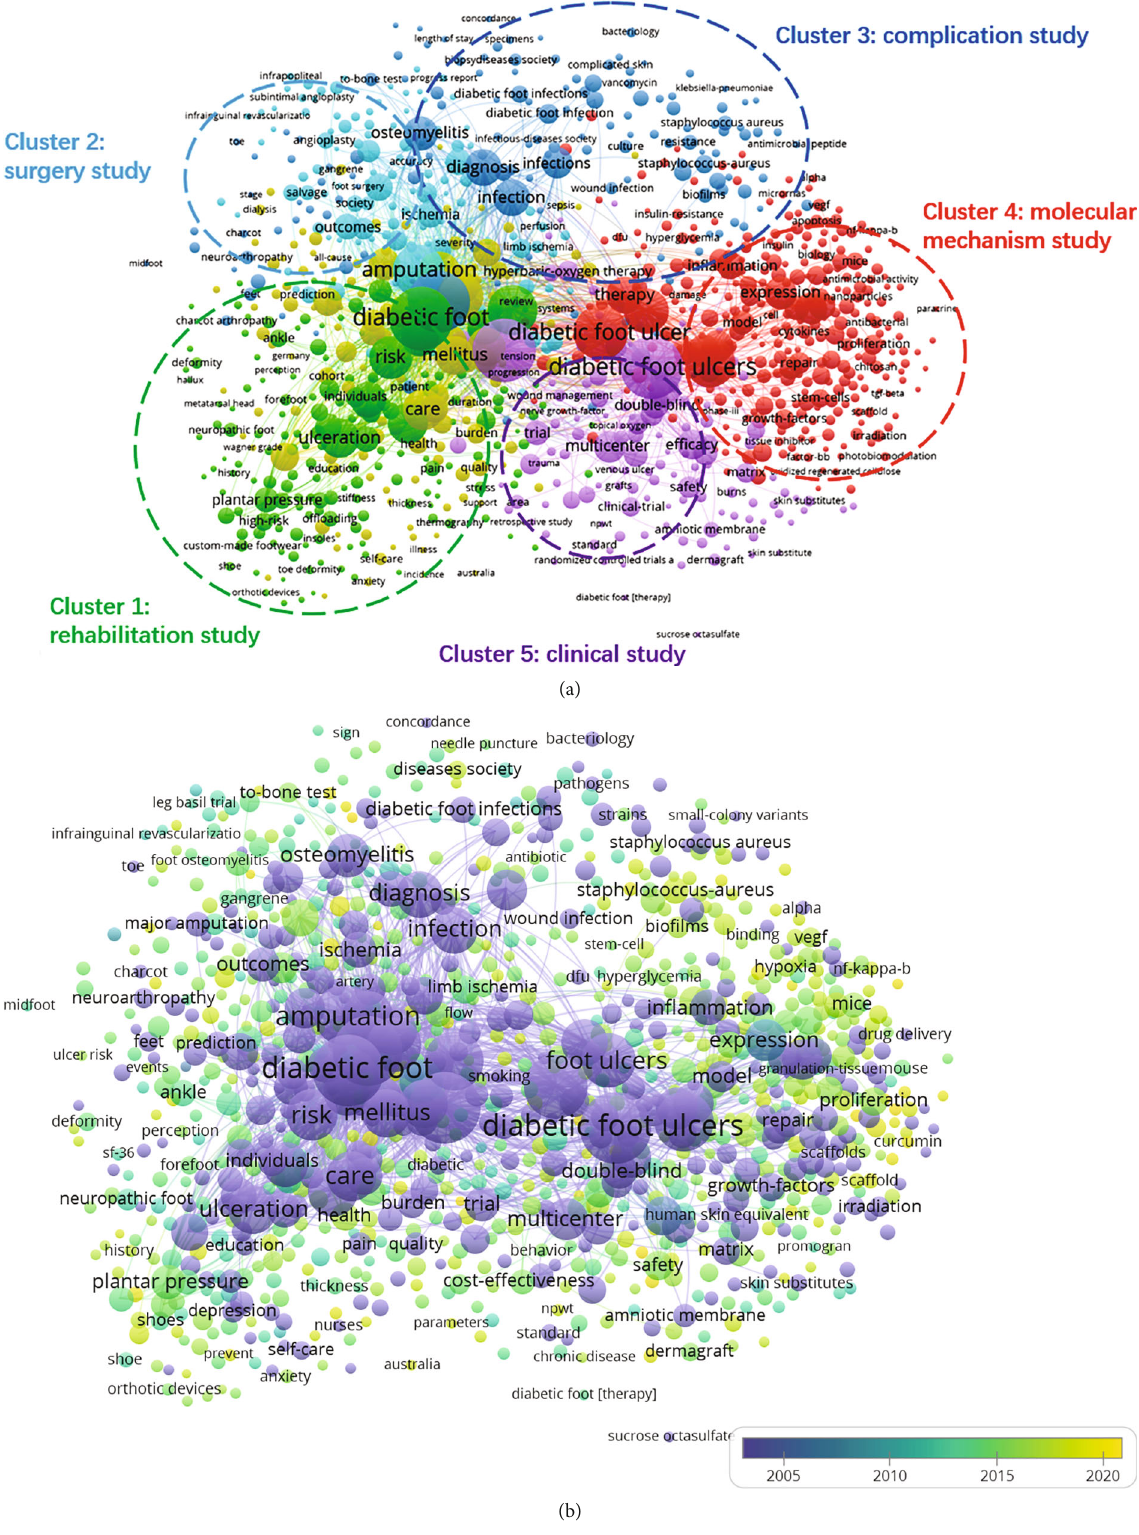
Figure 9: Cooccurrence analysis on DFU research. (a) Mapping of keywords on DFU research; the size of nodes represents the frequency, while the lines between nodes re fl ect the cooccurrence relationship. A total of 1000 included keywords were divided into fi ve clusters: rehabilitation study (green), surgery study (sea blue), complication study (dark blue), molecular mechanism study (red), and clinical study (purple). (b) Distribution of keywords according to the frequency of appearance. The colour blue indicates the keywords appear earlier, whereas the colour yellow re fl ects the later